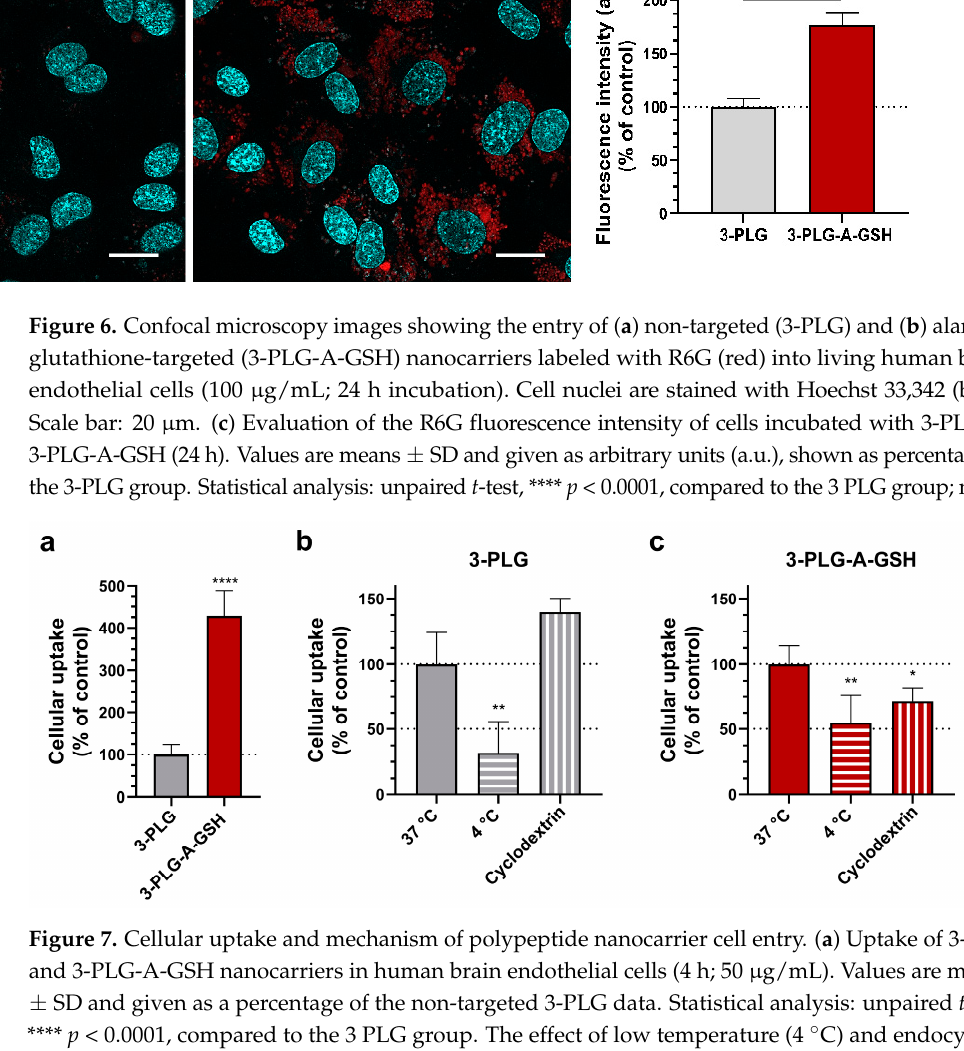
Figure 6. Confocal microscopy images showing the entry of ( a ) non-targeted (3-PLG) and ( b ) ala- nine–glutathione-targeted (3-PLG-A-GSH) nanocarriers labeled with R6G (red) into living human brain endothelial cells (100 μ g/mL; 24 h incubation). Cell nuclei are stained with Hoechst 33,342 (blue). Scale bar: 20 μ m. ( c ) Evaluation of the R6G fluorescence intensity of cells incubated with 3- PLG or 3-PLG-A-GSH (24 h). Values are means ± SD and given as arbitrary units (a.u.), shown as percentage of the 3-PLG group. Statistical analysis: unpaired t -test, **** p < 0.0001, compared to the 3 PLG group; n = 4.